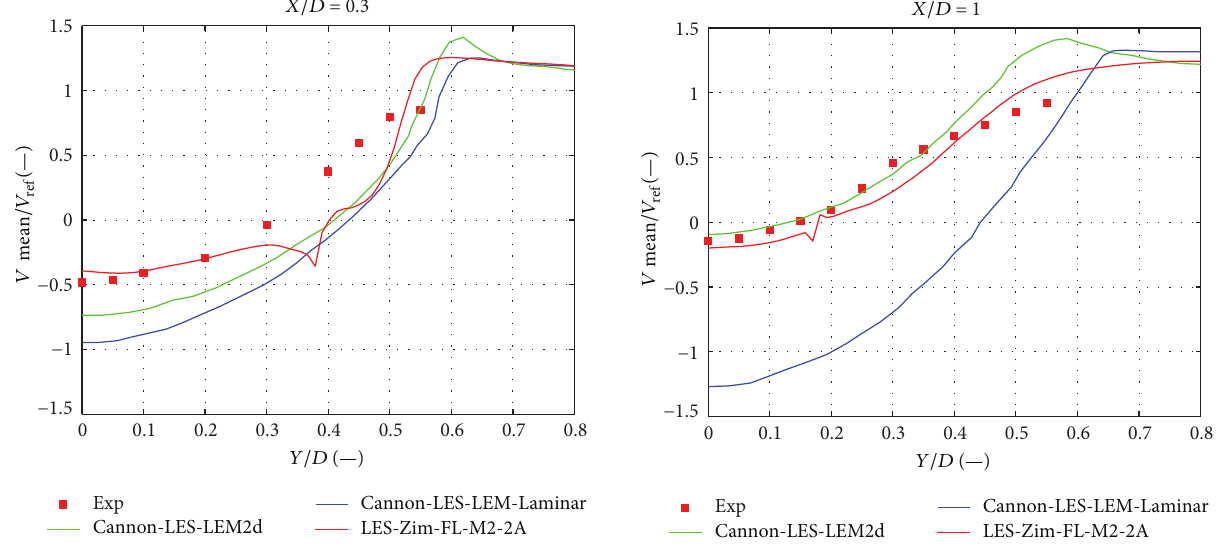
Figure 12: Mean axial velocity compared with Cannon et al. results